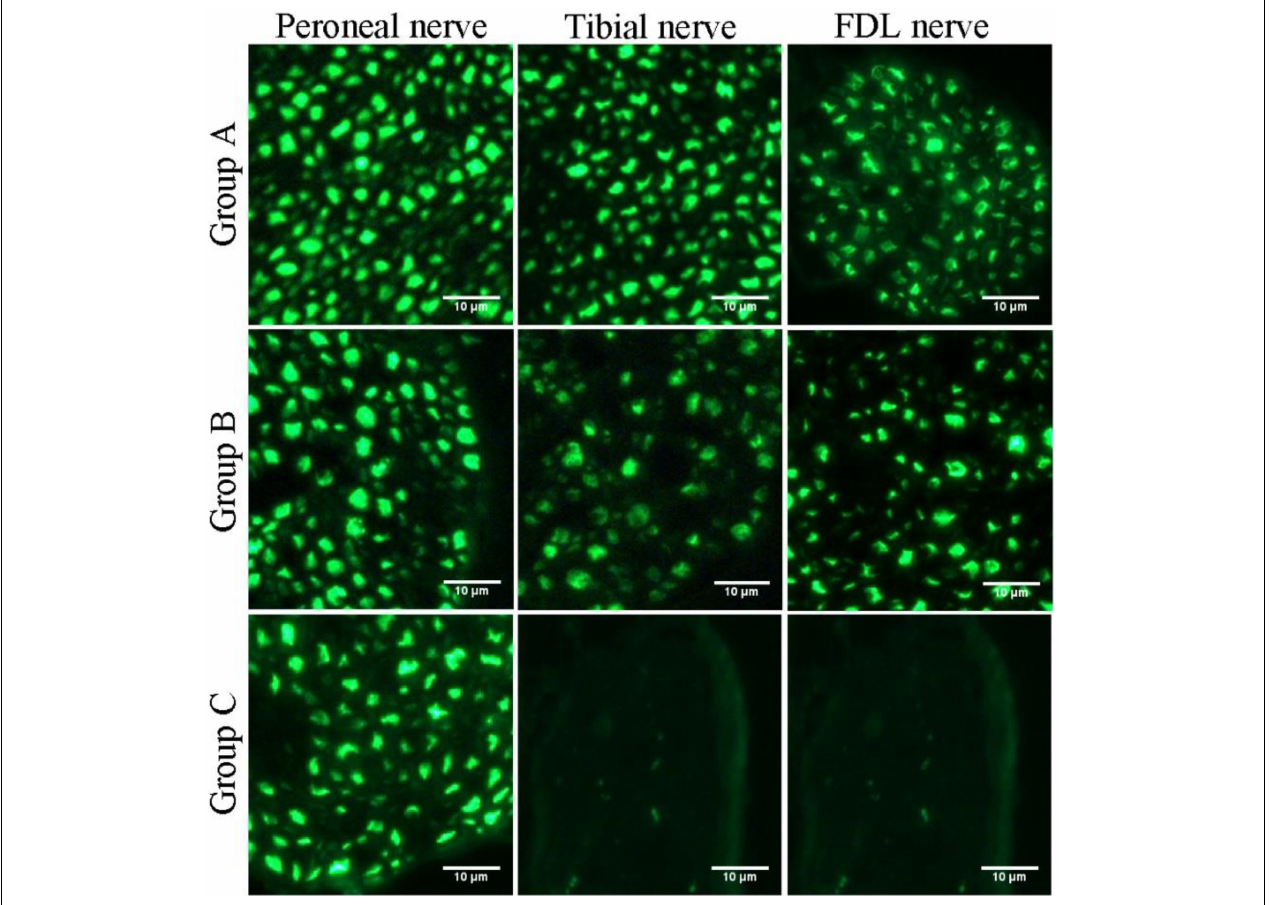
FIGURE 6 | Fluorescence microscopy images of transverse sections of the peroneal nerve, tibial nerve, and long flexor digitorum branch of the tibial nerve (FDL